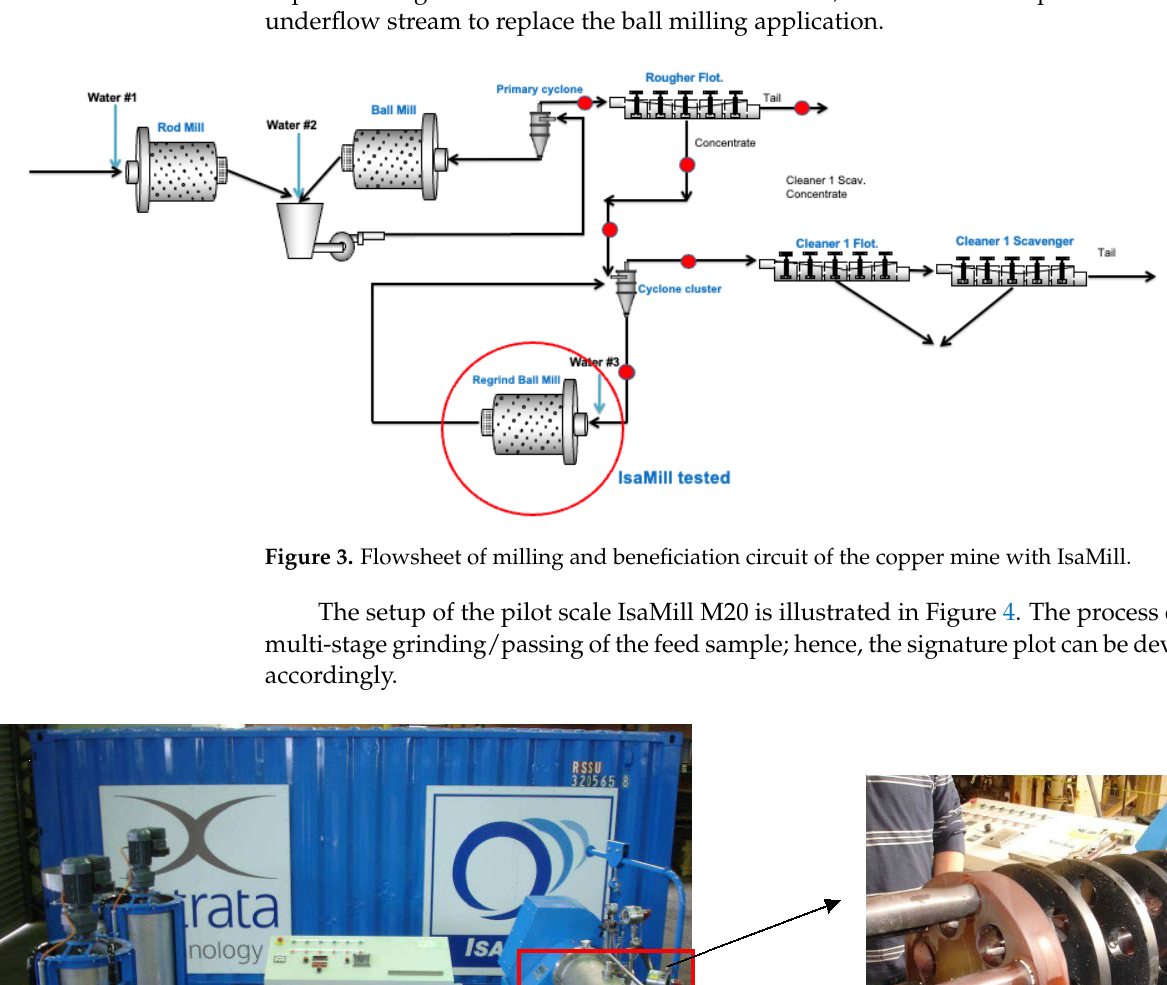
Figure 2. Flowsheet of milling & beneficiation circuit of the copper mine with HIGMill.